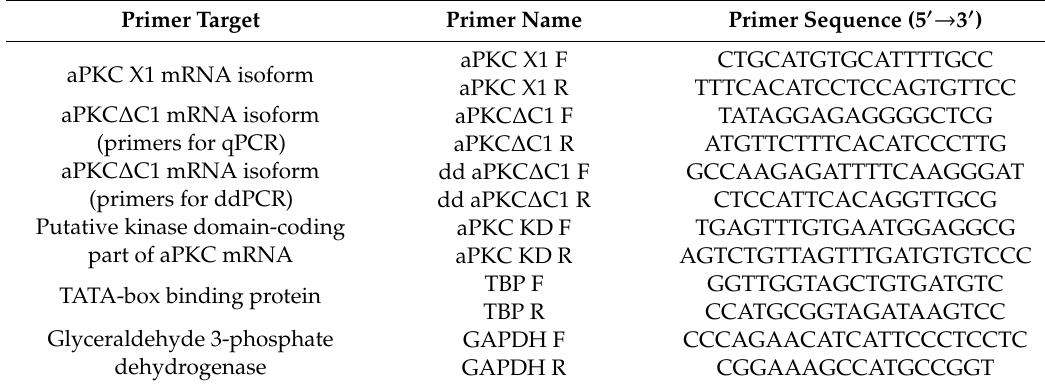
Table 2. Gene-specific primers designed to assess expression levels of aPKC mRNA